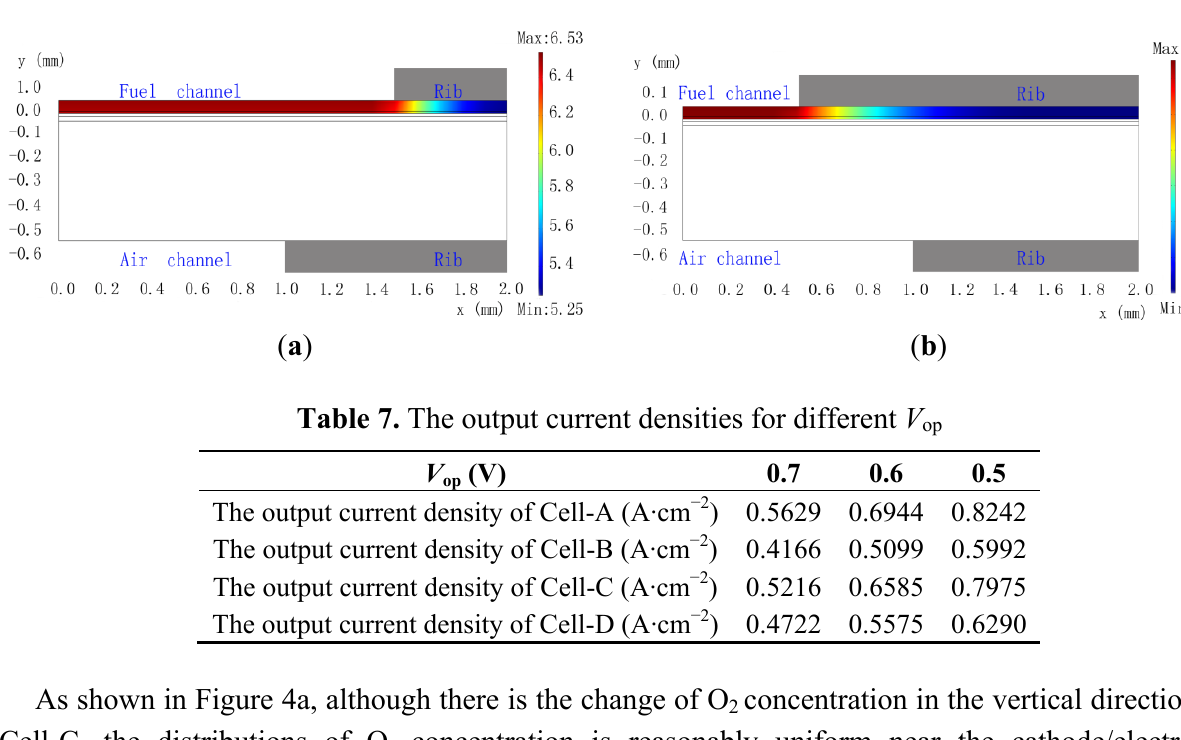
in ( a ) Cell-A and ( b ) Cell-B. 2